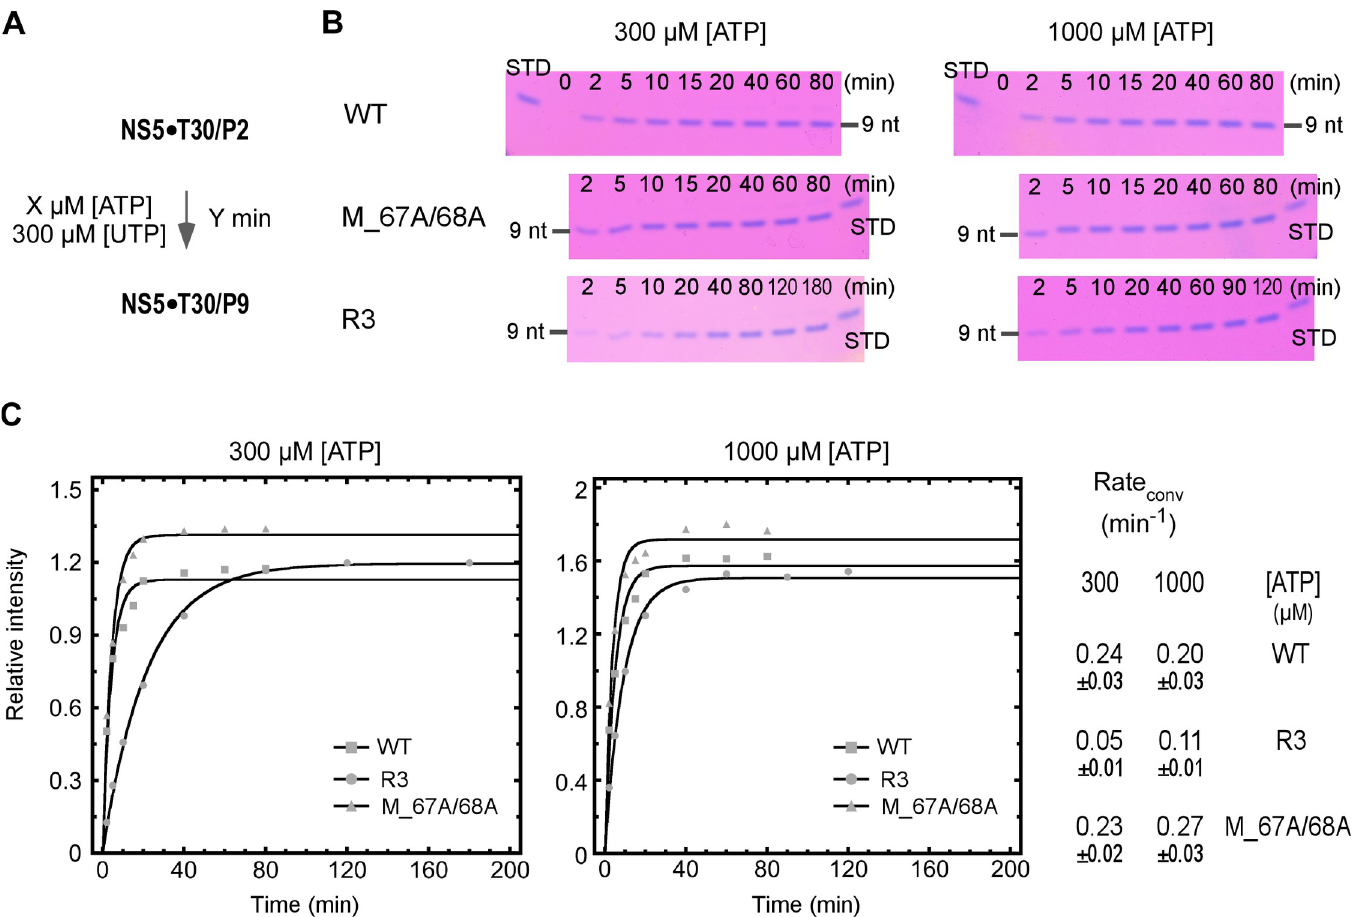
Fig 8. A comparison of P2 to P9 conversion of the WT DENV2 NS5 constructs confirmed the initiation impairment in the R3 mutant. A) Reaction flow chart. Two ATP concentrations (300 and 1000 μ M) were tested. B) The P9 accumulation was monitored over time for the WT, R3, and M_67A/68A constructs and the STD samples were used for quantitation (set to 1). C) The relative P9 intensity as a function of time was plotted for all three constructs under two ATP concentrations. The overall conversion rate (rate conv ) was estimated by fitting each data set to a single exponential rise